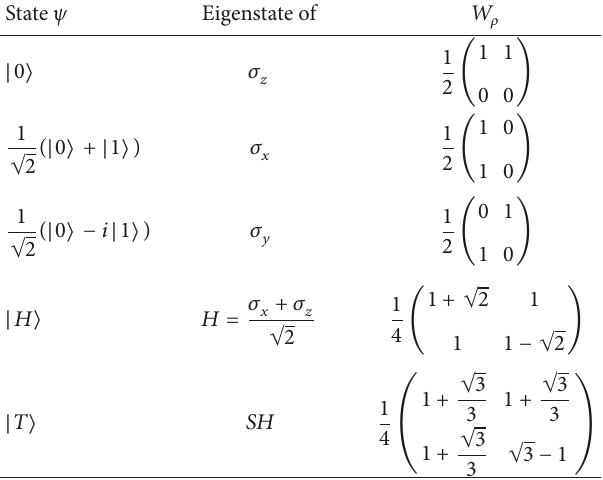
Table 1: Wootters discrete Wigner function for a few pure states 𝜌 = |𝜓⟩⟨𝜓|